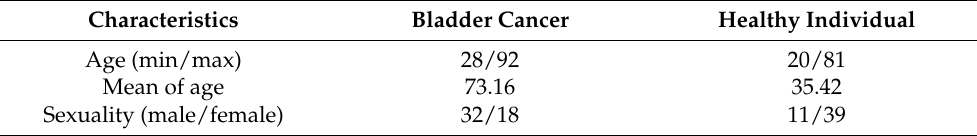
Table 1. The age and sex of 50 patients with bladder cancer and 50 healthy individuals.